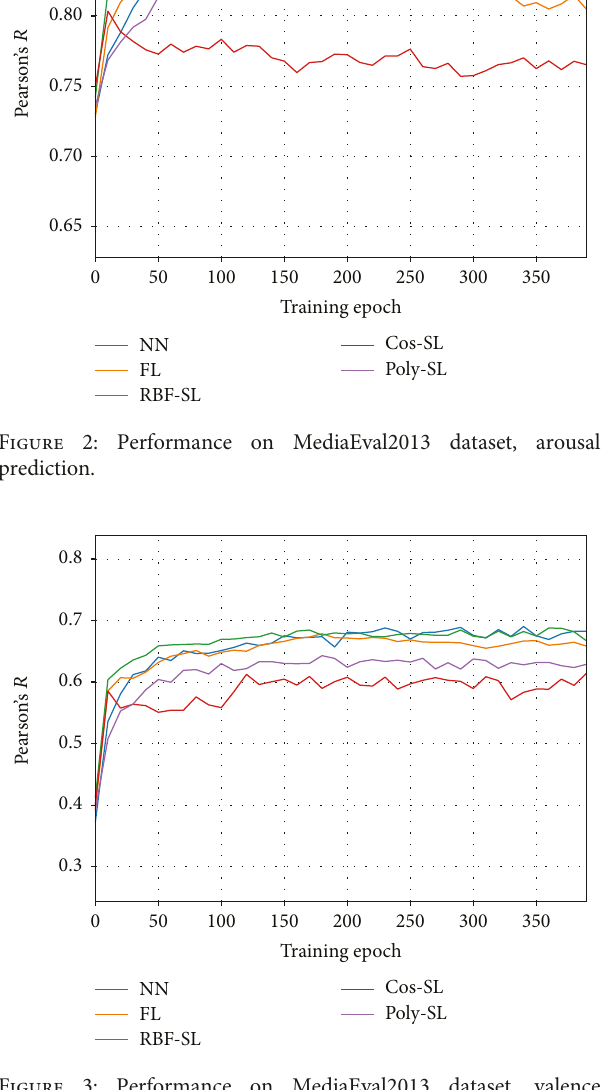
Figure 3: Performance on MediaEval2013 dataset, valence prediction.